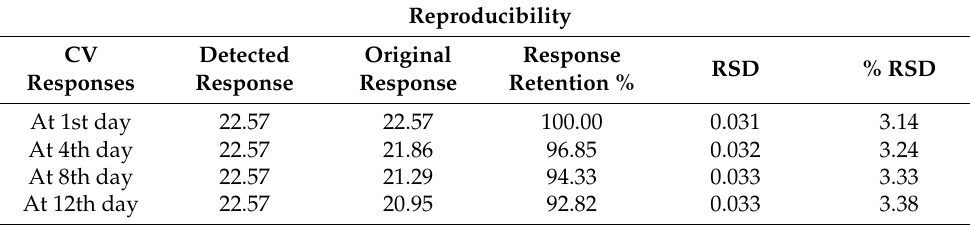
Table 4. Details of stability of the